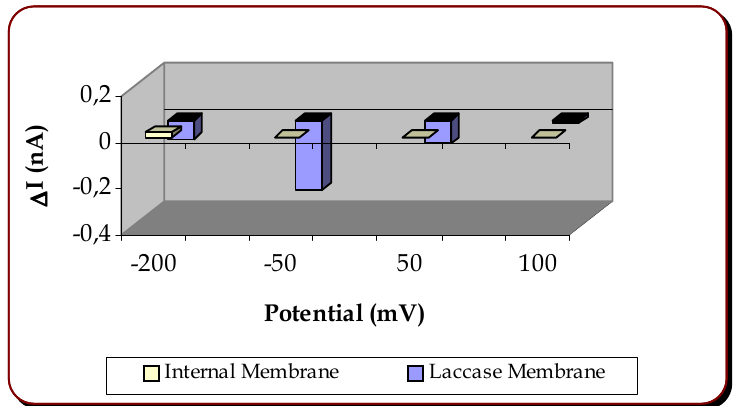
Figure 5. Relative responses to caffeic acid of the internal and laccase membrane when applied to the electrode base, at different applied potentials.